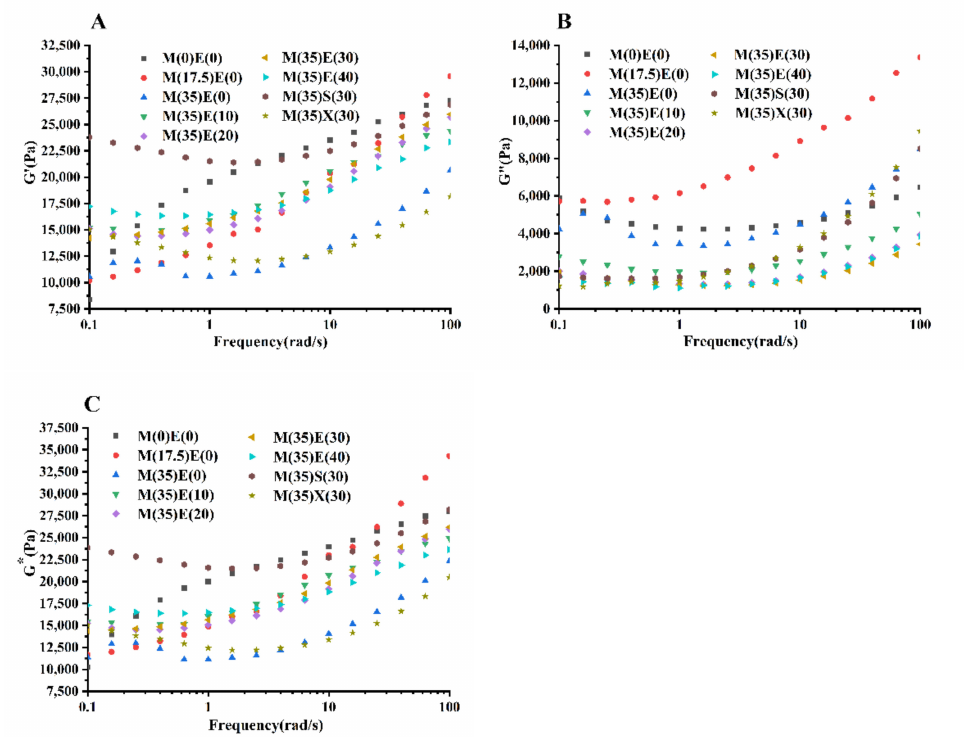
Figure 5. ( A ) Viscoelasticity properties of different inks within frequency of 1–100 rad/s conducted at room temperature 25 ◦ C. ( A ) Elastic modulus. ( B ) Viscous modulus. ( C ) Complex